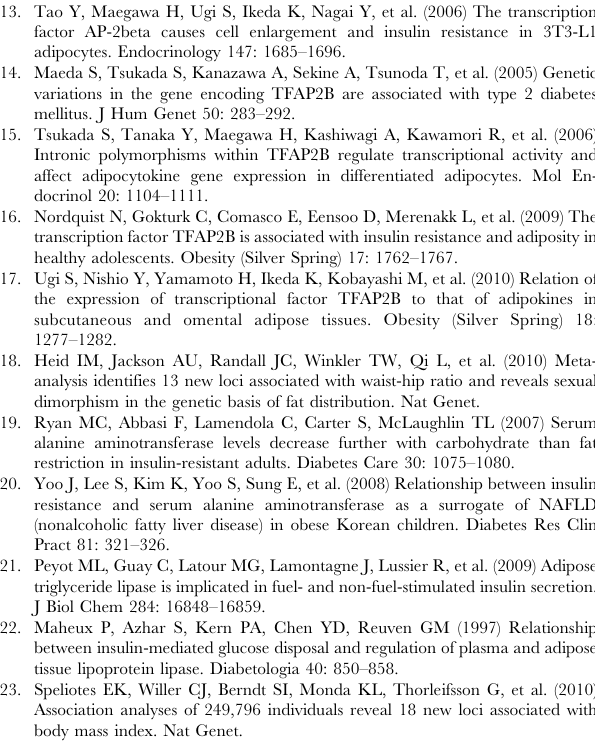
Table S6 Quantitative metabolic traits in 5,804 treat- ment-naı¨ve middle-aged Danes from the population- based Inter99 cohort according to MSRA rs545854 genotype. Data are unadjusted means 6 standard deviation or medians (interquartile range). Values of fasting serum triglycerides, serum insulin, plasma glucose, and HOMA-IR were logarithmi- cally transformed prior to statistical analyses, and their effect sizes ( b ) are presented as the increase/decrease in percent. P -values were calculated assuming an additive model ( p add ). Interaction analysis ( p int ) was performed to test whether the effect of the alleles differed between men and women. All analyses were adjusted for age, sex, and BMI. Furthermore, waist circumference and waist- hip ratio were adjusted for age and sex, and the p -values are shown in parentheses. Table S7 Quantitative metabolic traits in 5,764 treat- ment-naı¨ve middle-aged Danes from the population- based Inter99 cohort according to TFAP2B rs987237 genotype. Data are unadjusted means 6 standard deviation or medians (interquartile range). Values of fasting serum triglycerides, serum insulin, plasma glucose, and HOMA-IR were logarithmi- cally transformed prior to statistical analyses, and their effect sizes ( b ) are presented as the increase/decrease in percent. P -values were calculated assuming an additive model ( p add ). Interaction analysis ( p int ) was performed to test whether the effect of the alleles differed between men and women. All analyses were adjusted for age, sex, and BMI. Furthermore, waist circumference and waist- hip ratio were adjusted for age and sex, and the p -values are shown in parentheses. Table S8 Statistical power estimates. Central overweight: , 4,500 controls and , 3,700 overweight individuals. Preva-